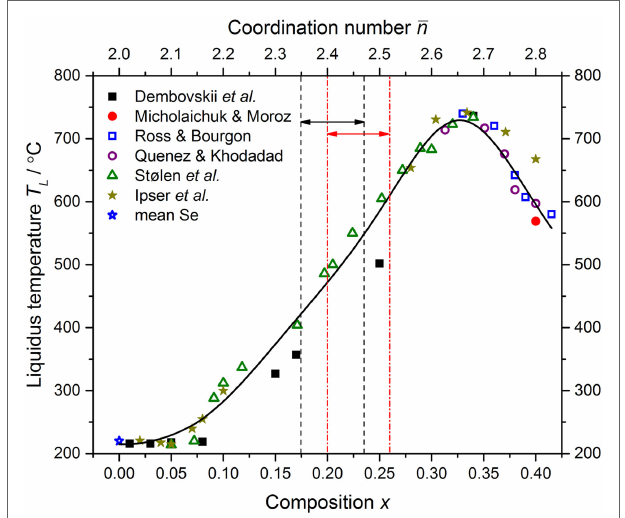
FIGURE 1 | The dependence of the liquidus temperature T L for the Ge x Se 1 (cid:0) x system on the composition x and mean coordination number ¯ n = 2 ( 1 + x ) . The data point for Se is a mean of the values reported by Berkes and Myers (1971), Johnson et al. (1986), Morgant and Legendre (1986), Ota and Kunugi (1973), and Stølen et al. (1999). The other data points were taken from Dembovskii et al. (1965), Ipser et al. (1982), Mikolaichuk and Moroz (1986), Quenez and Khodadad (1969), Ross and Bourgon (1969), and Stølen et al. (1999). The solid (black) curve gives a least-squares fit of the measured data sets to an inverse polynomial function. The pairs of vertical dashed (black) or chained (red) lines, and associated horizonal arrows, mark compositions for which ∆ H nr ≃ 0 as found in the present work or in the work of Boolchand et al. (2001a),